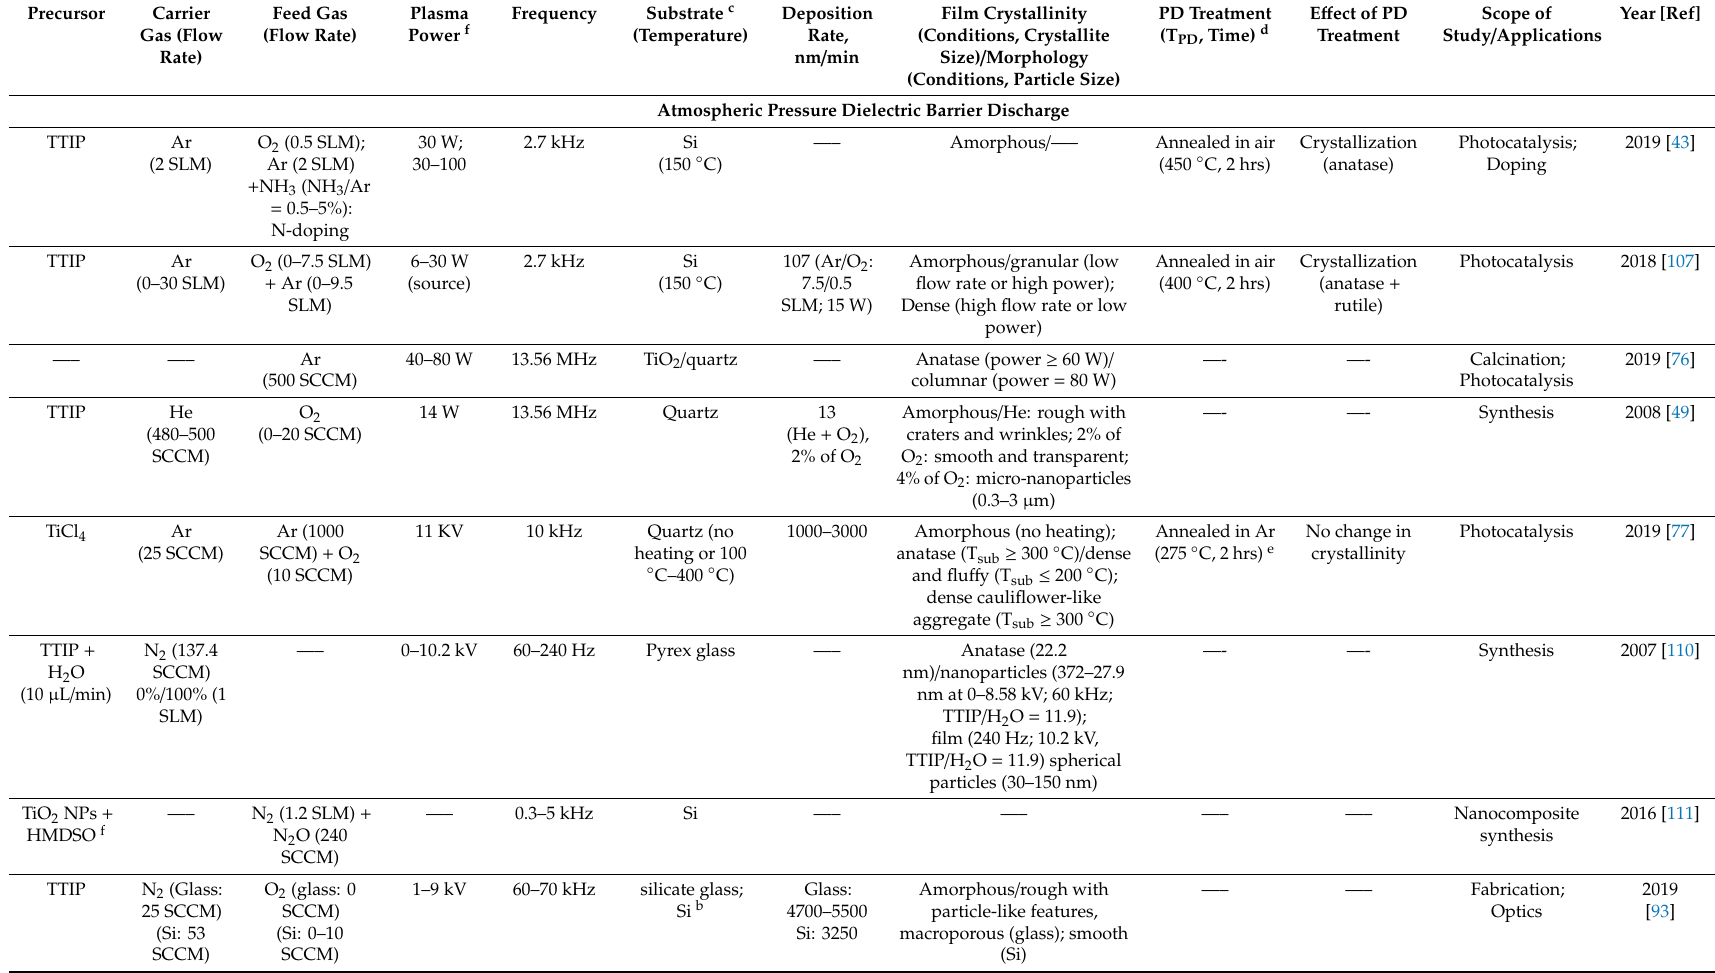
Table 3. Summary of deposition and plasma parameters for DBD-based TiO 2 deposition techniques including deposition rate, crystallinity, and morphology of as-deposited film along with post deposition treatment and its e ff ect on the films.